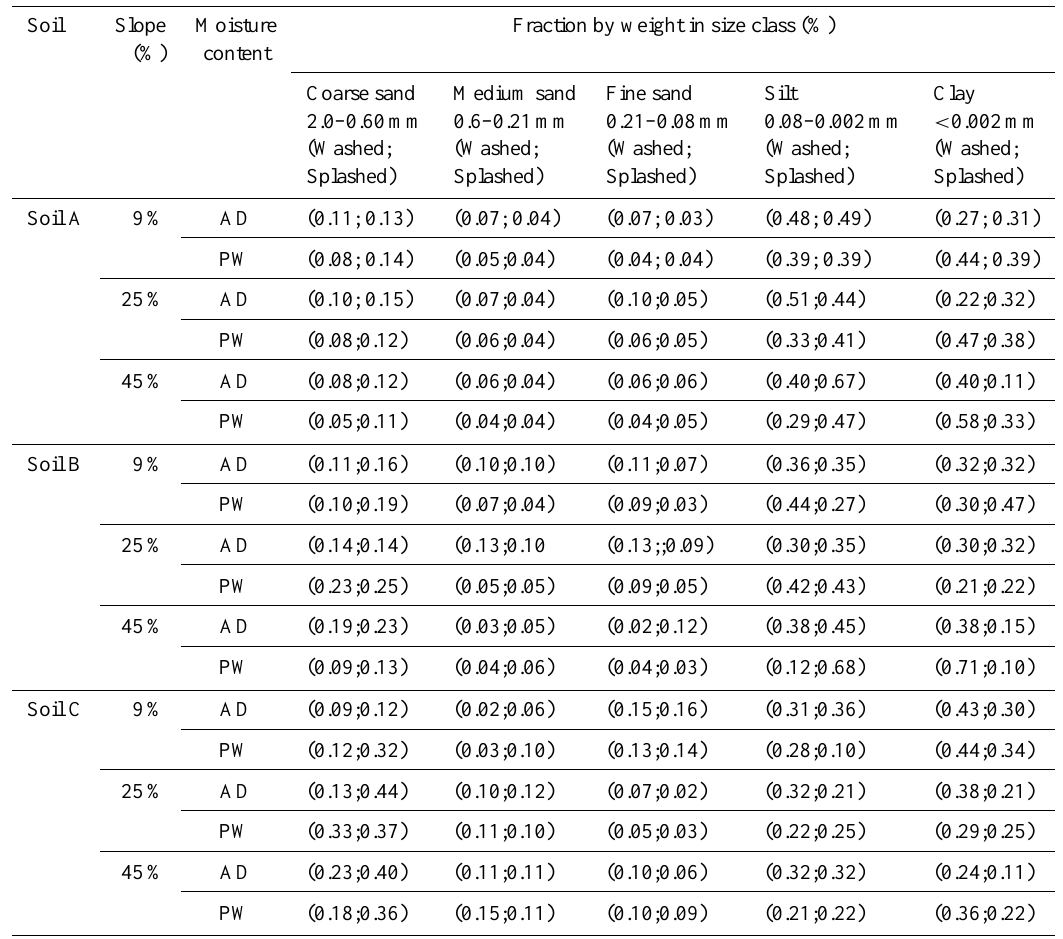
Table 8. Size distribution of the washed and splashed sediment for the three soils.